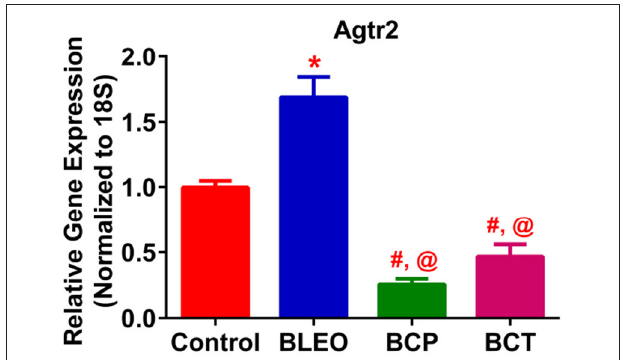
FIGURE 8 | C21 treatment attenuates the expression of Angiotensin type 2 receptor in BLEO animals. Treatment of BLEO animals with C21 attenuated the expression of Agtr2 in the lungs. Data represented is mean ± SEM, n = 5 animals/group. *Indicates a p -value of ≤ 0.05, comparing BLEO animals against the controls. #Indicates a p -value of ≤ 0.05, comparing BCP and BCT vs. BLEO. @ indicates a p -value of ≤ 0.05, comparing BCP and BCT vs. control.